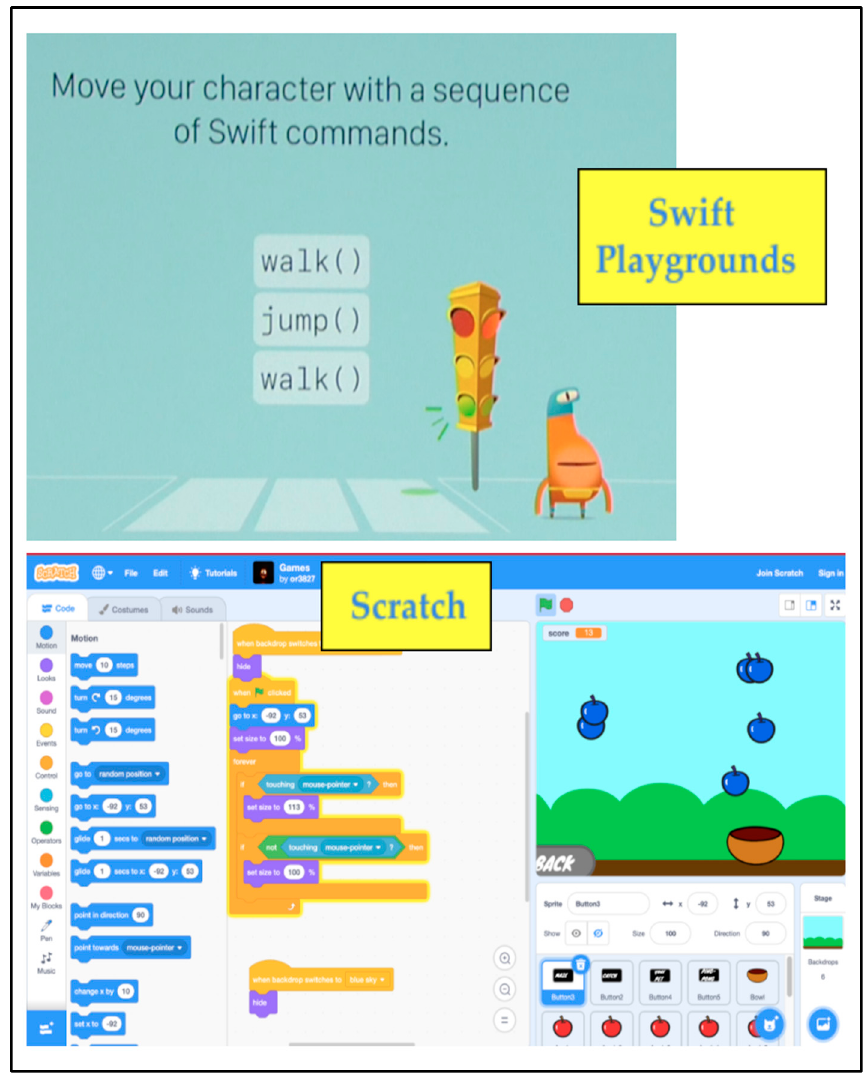
Figure 1. Tools for code learner: Swift Playgrounds from Apple and Scratch from MIT.